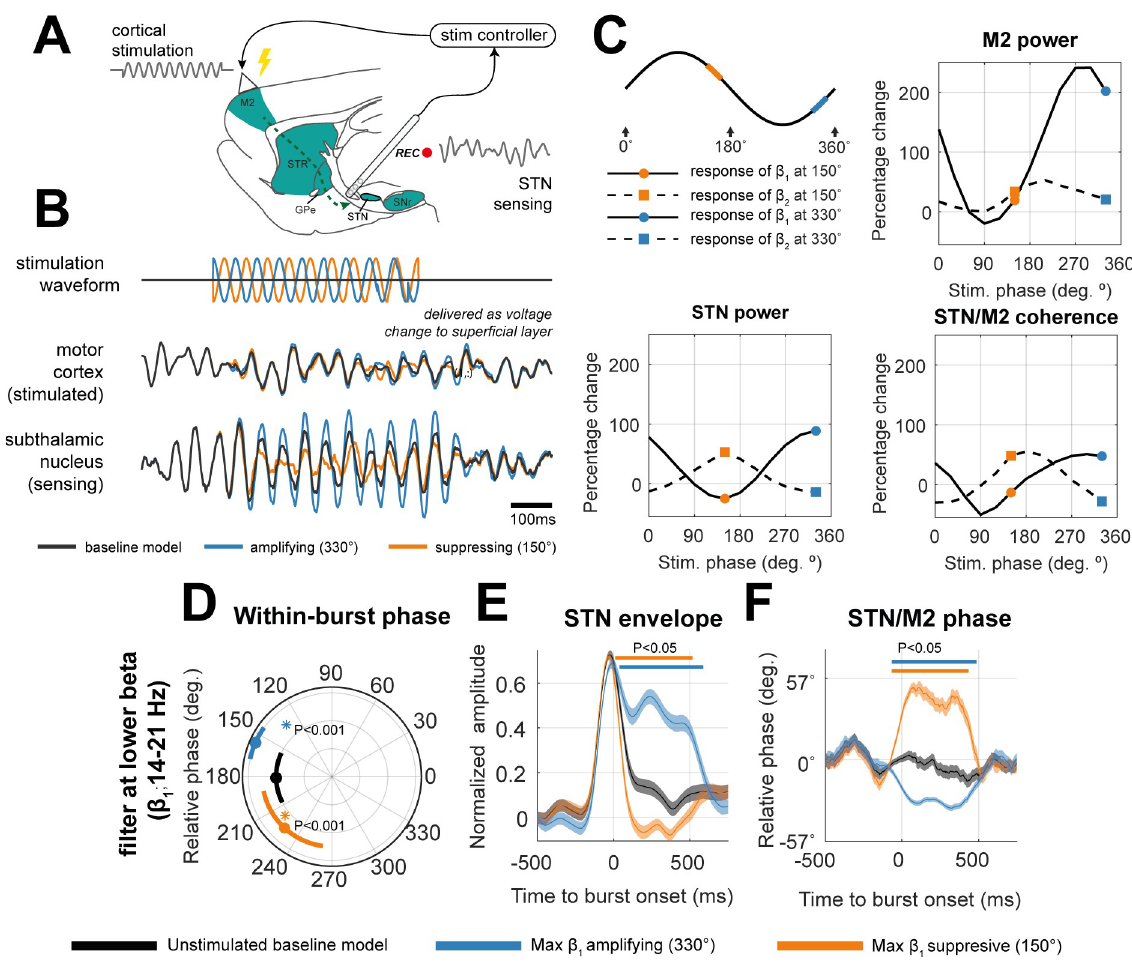
Fig 4. A model of dual-site controlled motor cortical stimulation phase locked to signals sensed in the subthalamic nucleus, can modulate beta activity across the network. (A) Schematic for phase specific neuromodulation in the rodent brain. Activity at the STN is used to gate stimulation delivery at M2. (B) Stimulation waveforms were generated using an 18 Hz sinusoid, with phase constructed to be offset against an on-line phase estimate of STN activity. Stimulation was delivered as a direct voltage injection to the stimulated population (superficial layer of M2). Effects upon β power were either amplifying (blue; 330˚) or suppressing (orange; 150˚) depending on the phase. (C) Amplitude response curves of power in the motor cortex, STN, as well as their synchronization (in terms of coherence) when sweeping across 12 stimulation phases. Curves are shown separately for lower ( β 1 ; bold line) or upper beta ( β 2 ; dashed line). Corresponding spectra are shown in supplementary S5 Fig. (D) Analysis of mean M2/STN phase difference during stimulation period (centred relative to the mean phase at 0˚) filtered at lower beta frequencies. Circular markers indicate median, with bars giving the circular standard deviation. � indicate significant Rayleigh test for difference in phases from the unstimulated, fitted model. Note that the radial dimension has no meaning, bars are offset for presentation purposes. Angular lengths should be interpreted with relation to the grid-lines. (E) Analysis of the STN amplitude envelope during stimulation. (F) Analysis of M2/STN phase difference tracked across time. Traces are mean+/- S.E.M time locked to burst onset at t = 0. Bars indicate significant cluster-statistics for deviation from the unstimulated model (two-sample t-test, n = 500, α <